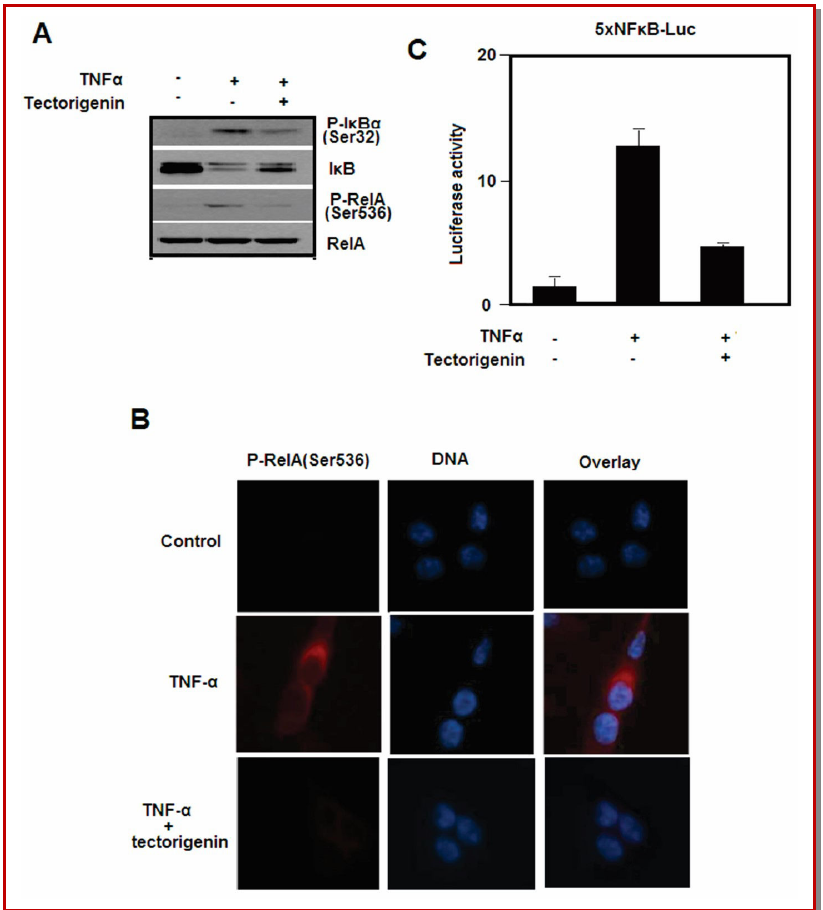
Figure 6: Tectorigenin inhibitory effect on TNF- α induced activation of NF- κ B . (A) Caco-2 cells alone or treated with 10 ng/mL TNF- α plus tectorigenin (20 µM) for 12 hours. (B) Caco-2 cells tectorigenin (20 µM) for 30 min before stimulation with TNF- α (10 ng/mL) for 30 min. The overlay images are shown on the right. (C) Caco-2 cells alone or treated with 10 ng/mL TNF- α plus tectorigenin (20 µM) for 8 hours and luciferase activity was measured. All the data shown indicated the mean ± SD for one exper- iment performed in